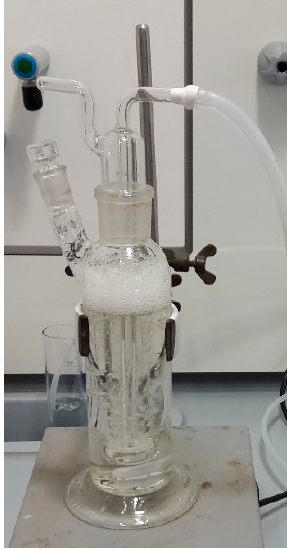
Figure 6. Glass bubble column reactor.